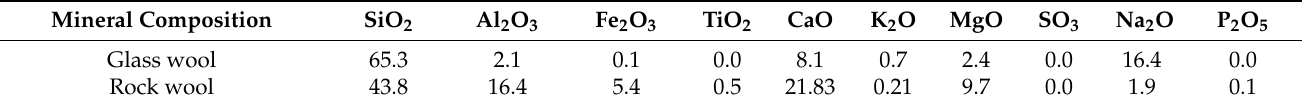
Table 2. Chemical composition of the mineral